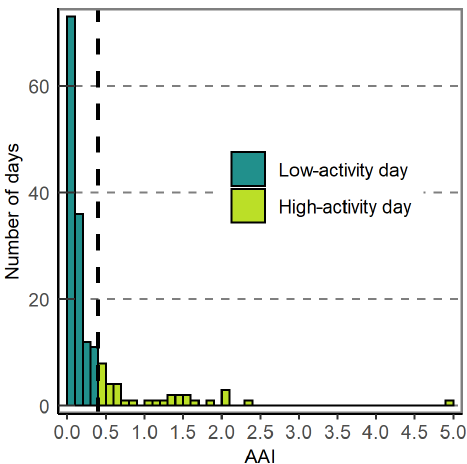
Figure 3. Distribution of the calculated daily AAI for days where AAI > 0. The dashed black vertical line illustrates the 0.4 AAI threshold above which days were classified as high-activity days ( n = 34) and below which days were classified as low-activity days ( n =